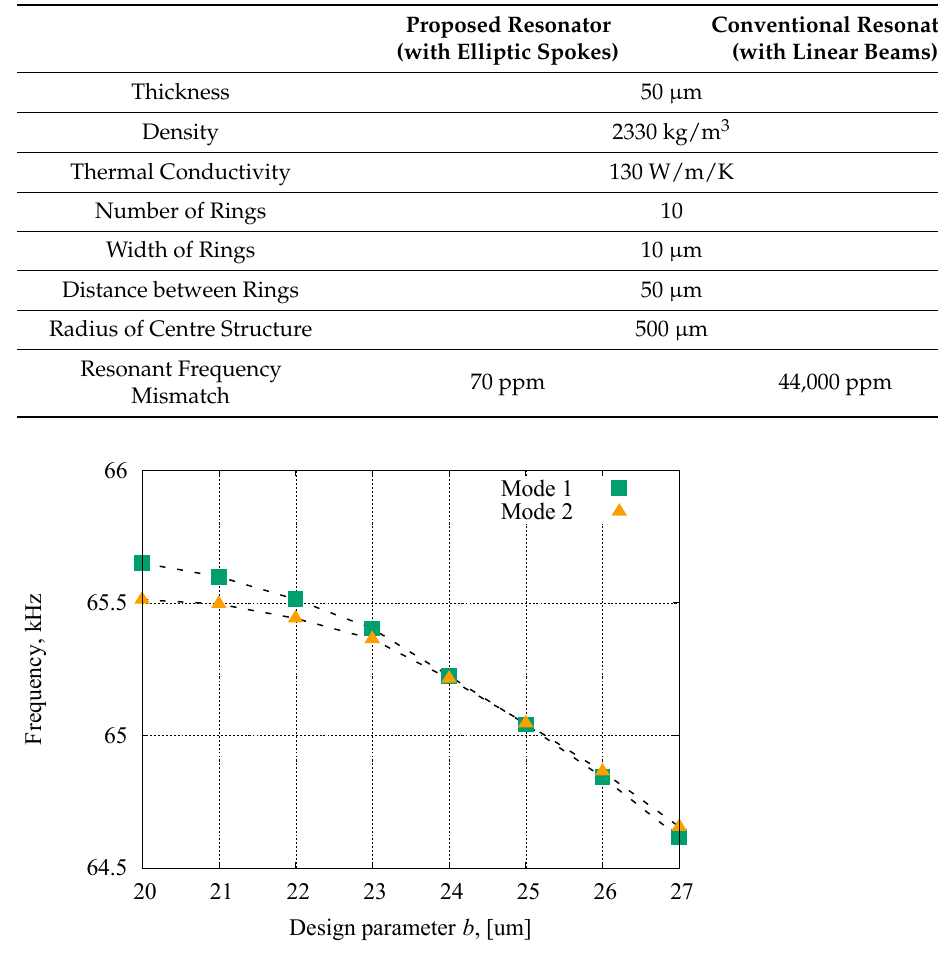
Figure 5. Dependency of resonance frequencies of Mode 1 (<100> direction) and Mode 2 (<110> direction) on the design parameter b.